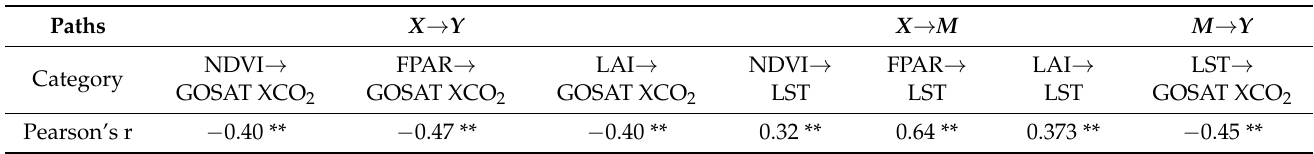
Table 3. Results of Pearson’s r among mediator (LST), independent (NDVI, FPAR, LAI) and depen- dent variables (GOSAT Level4 XCO 2